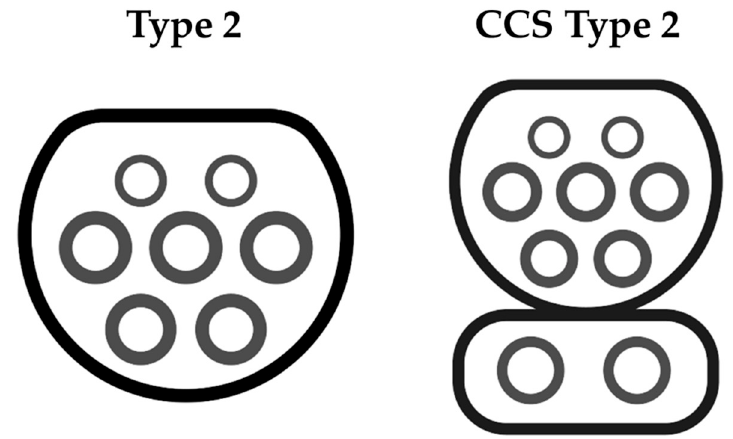
Figure 5. Type 2 and CCS Type 2 ports at EV charging stations in Malaysia.